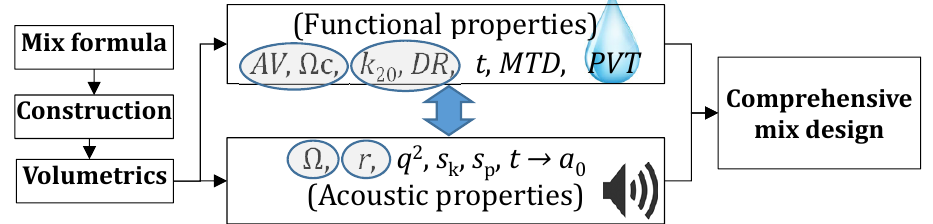
Figure 1. Summary of the